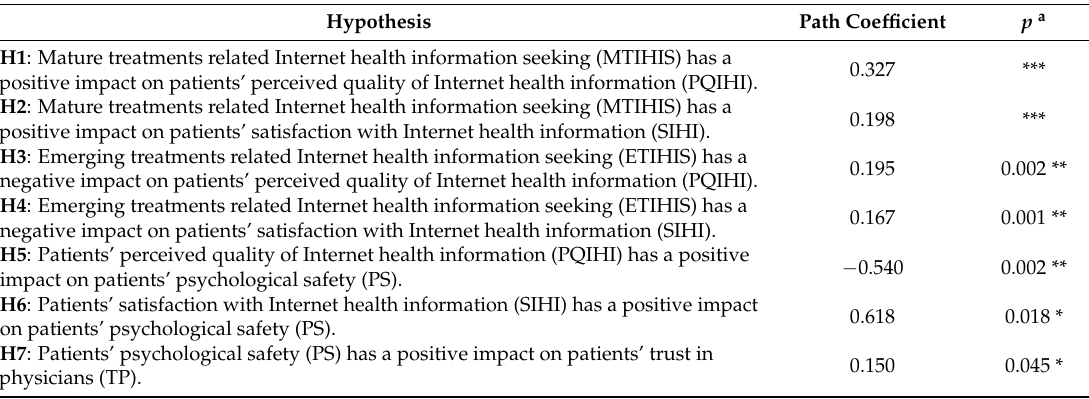
Figure 2. Research Model with Path Coefficients and Significances. Table 6. Hypotheses Testing Results.